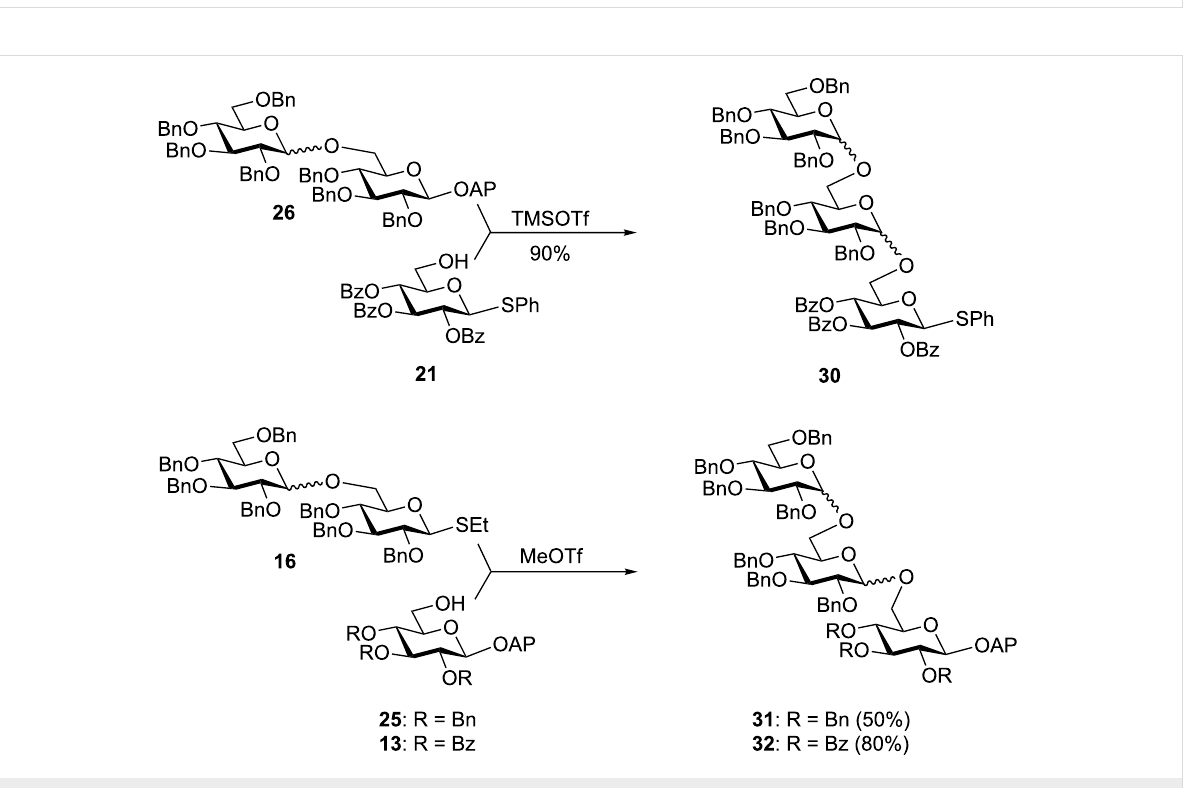
Scheme 3: AP building blocks in oligosaccharide